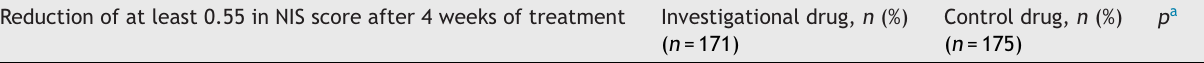
Table 3 Comparison of the proportions of patients with a reduction of at least 0.55 in NIS score after four weeks of treatment in both groups, PP population ( n = 346). Reduction of at least 0.55 in NIS score after 4 weeks of treatment